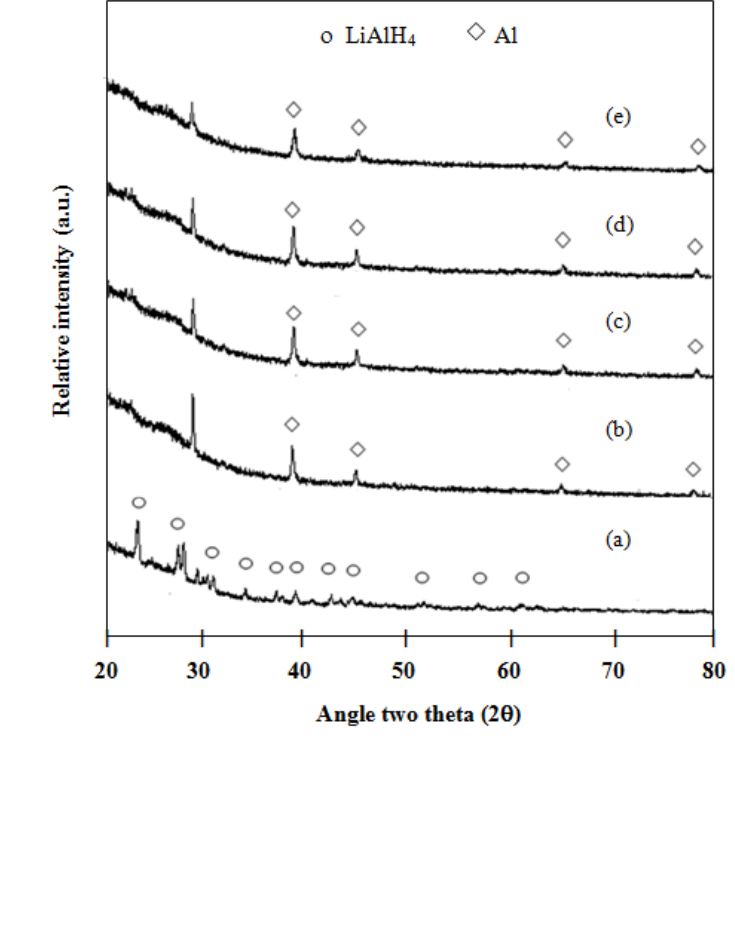
Figure 4. XRD patterns of milled samples for 120 min: ( a ) 2LiAlH ( b ) 1 mol % ZrCl –2LiAlH TiCl 3